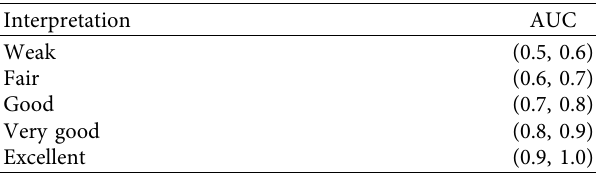
Figure 4: Bayesian optimization flowchart. Table 3: AUC value interpretation.